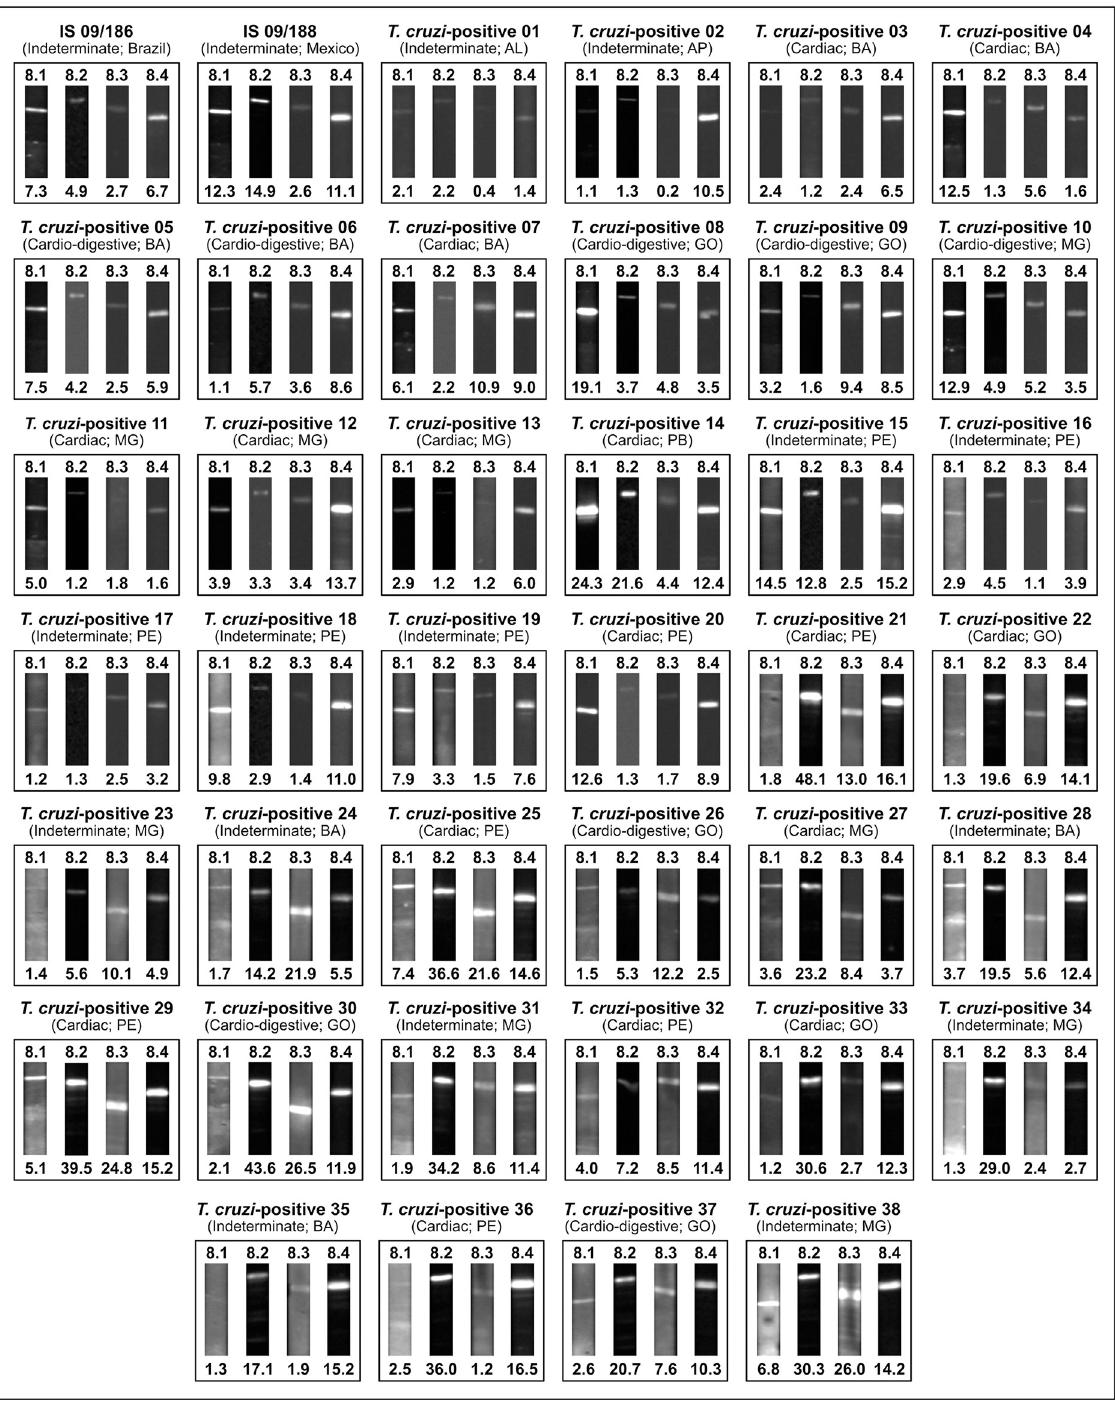
PLOS NeglectedTropical Diseases | https://doi.org/10.1371/journal.pntd.0010944 November28,